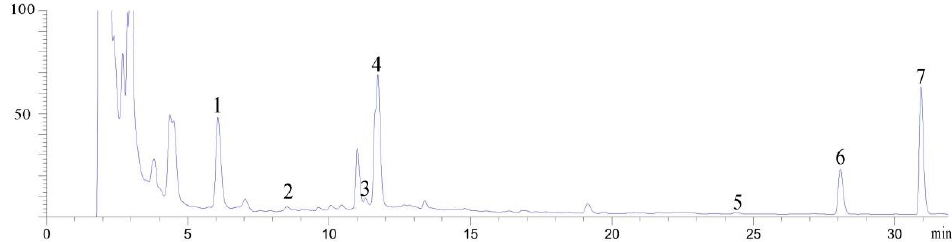
Figure 3. The established fingerprint of Astragali radix. 1-astragaloside V 2-astragaloside IV 3-astragaloside III 4-astragaloside II 5-astragaloside I 6-isoastragaloside I 7-isoastragaloside II.